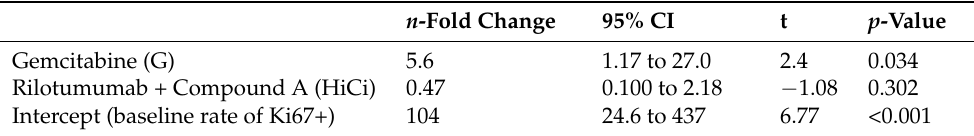
Table A5. Model specification for Figure 2b: Linear regression model of Ki67 positivity versus treatments. n -Fold Change 95% CI t